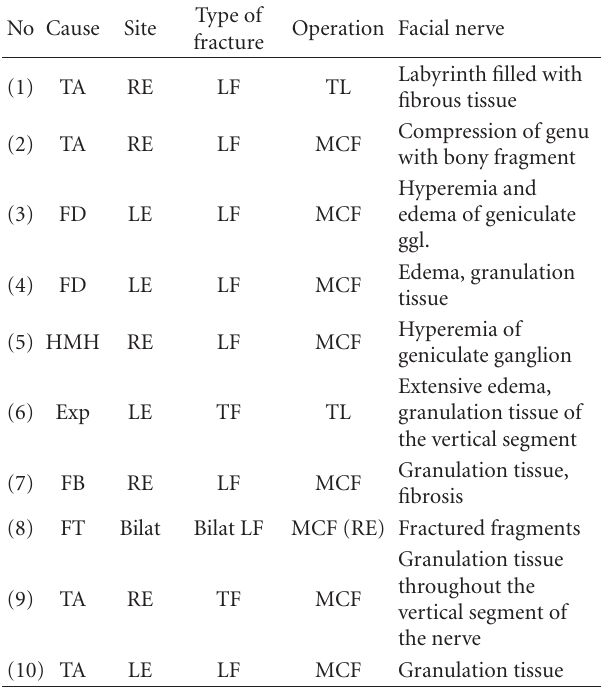
Table 1: Intraoperative findings of facial nerve (TA: tra ffi c accident, LF: longitudinal fracture, TL: translabyrinthine, MCF: middle cran- FB: falling from bicycle, FT: falling from truck, RE: right ear, and